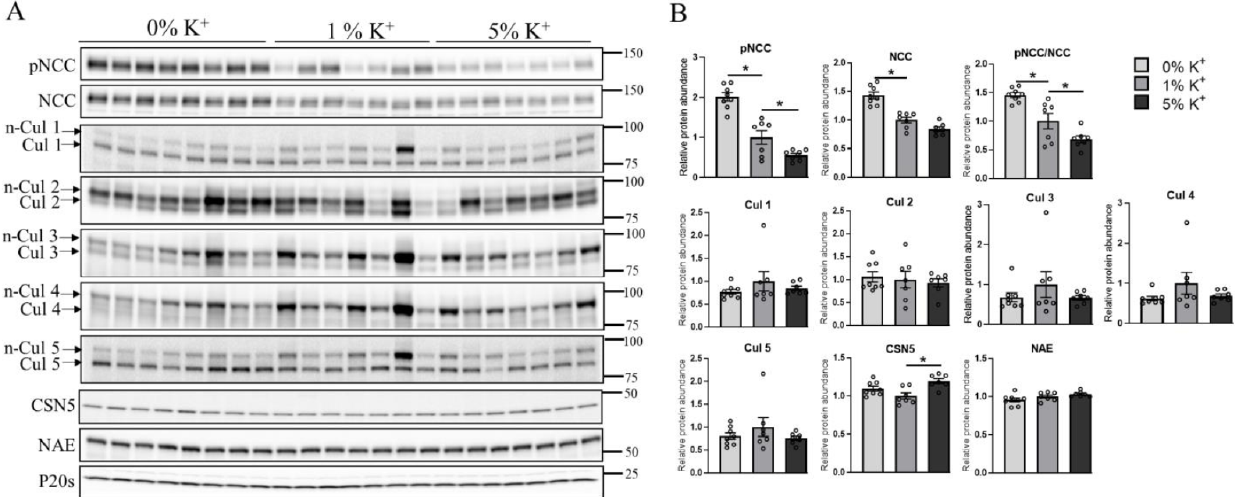
Figure 1. Increase in dietary K + supplementation decreases renal abundance of phosphorylated and total NCC in mice without altering cullin expression. ( A ) Representative immunoblots of pNCC, NCC, cullins (neddylated: n-Cul and non-neddylated: Cul), CSN5, NAE, and P20s in kidney homogenates of mice placed on a 0% K + ( n = 8), 1% K + ( n = 7), or 5% K + ( n = 7) diet. Molecular weight markers (kDa) are shown on the right. ( B ) Summarized relative protein abundance data. Each bar represents mean ± SEM and each dot represents value from an individual mouse. * indicates p < 0.05 relative to mice that were on 1% K + diet.